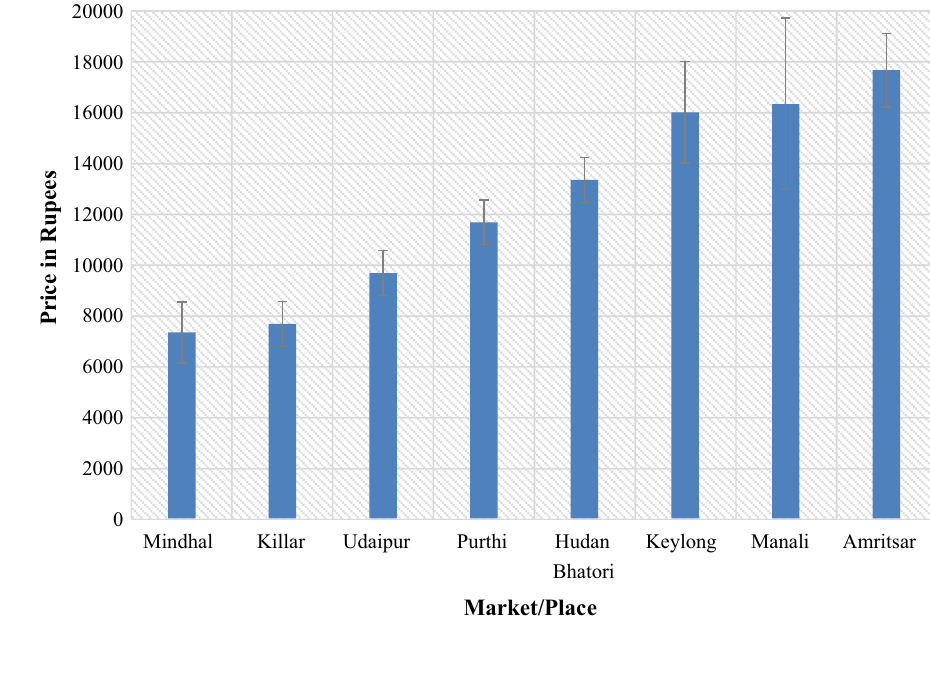
Fig. 4 Market price (Rs./ kg ± SE; n = 15) of Fritillaria cirrhosa in different markets (village/town/city)